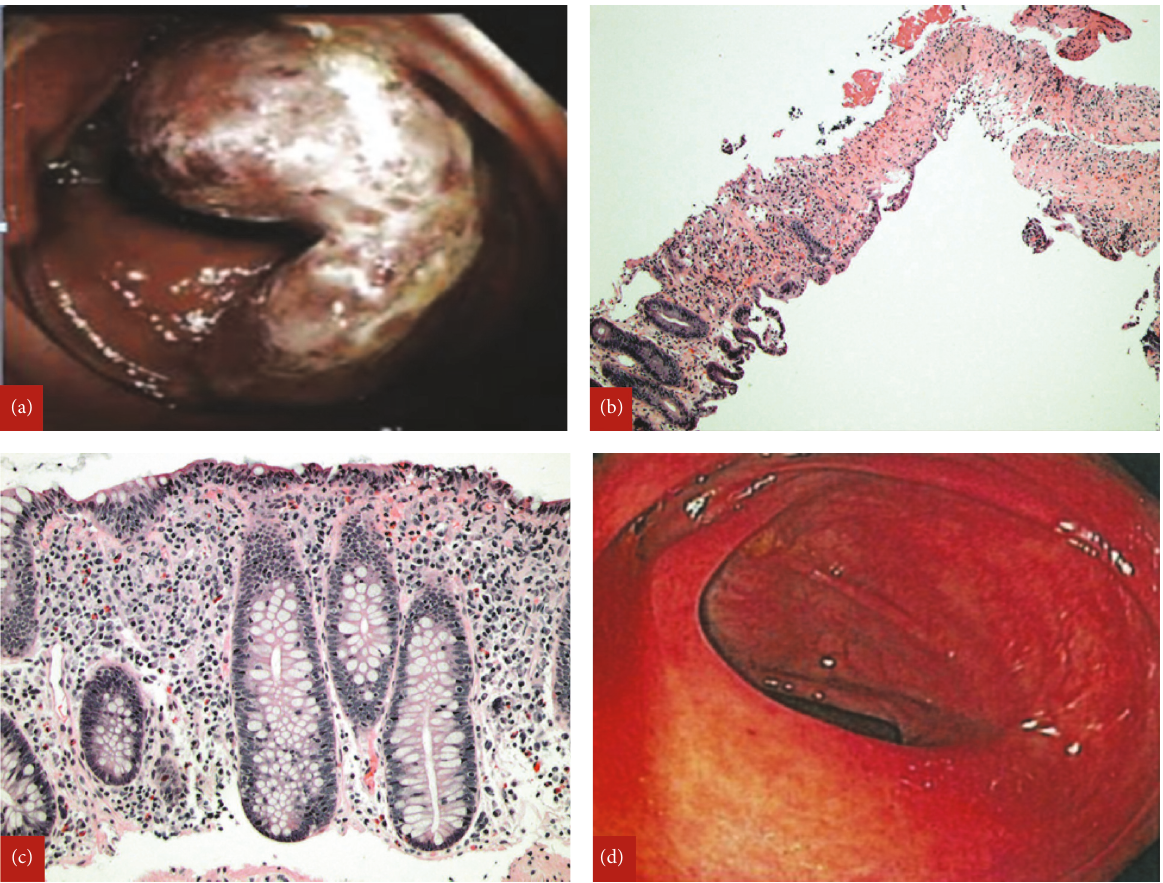
Figure 1: Initial colonoscopy findings showing mass-like lesion at the ileocecal valve (a). Biopsies of the ileocecal valve mass lesion demonstrating ischemic colitis ((b), original magnification x40). Background colonic biopsies demonstrating increase in intraepithelial lymphocytes, expansion of the lamina propria, and surface epithelial damage consistent with incidentallymphocytic colitis ((c), H&E original magnification x200). Follow-up colonoscopic image of ileocecal valve with complete resolution of the mass-like lesion